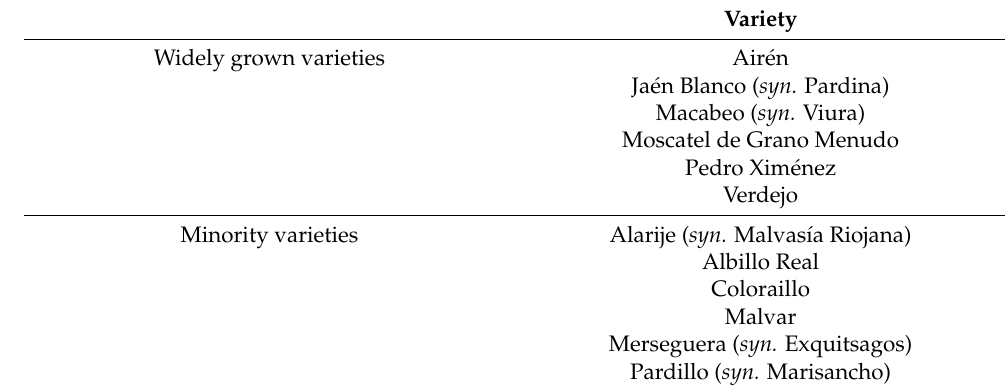
Table 1. List of 12 studied white grapevine varieties.